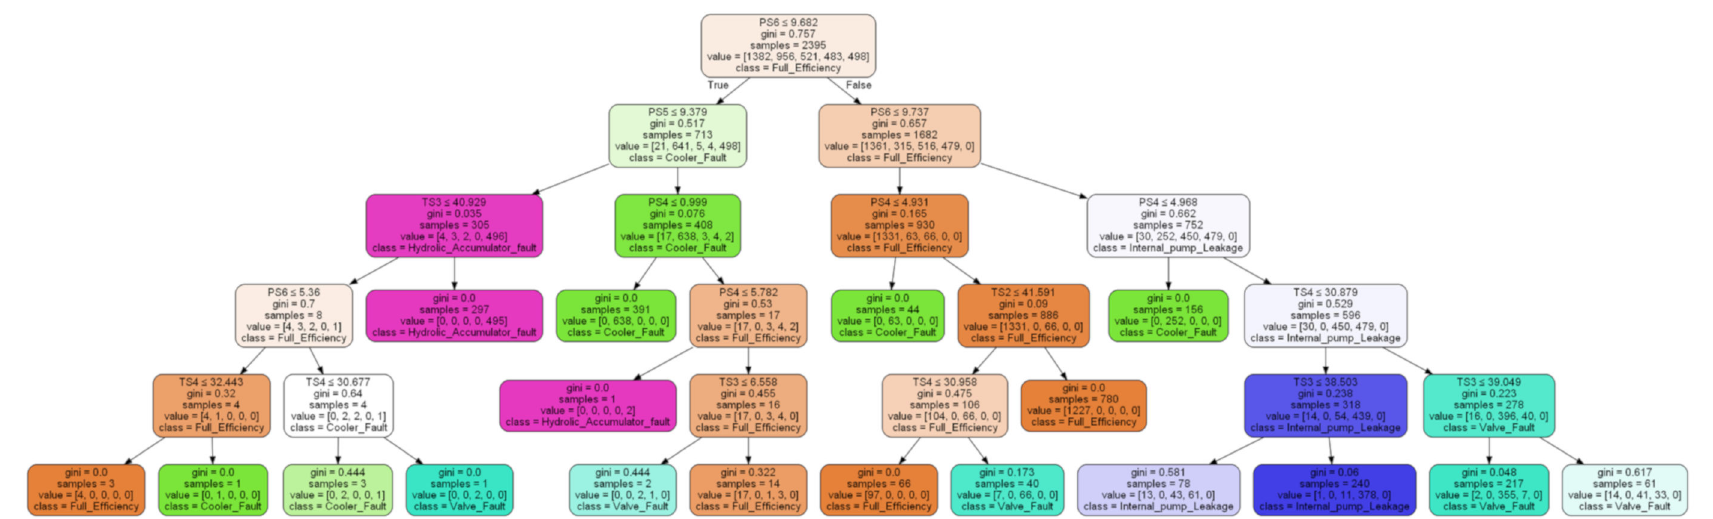
Figure 3. One of The Decision Trees in The RF After Feature Selection and Hyperparameter